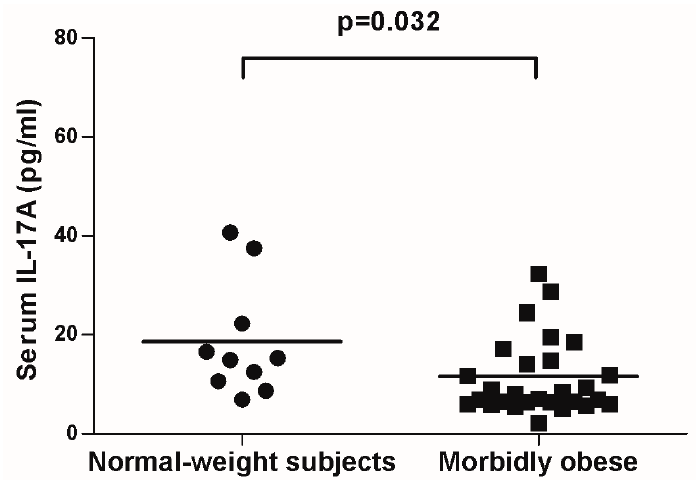
Figure 3. Circulating levels of IL-17A in normal-weight subjects (BMI < 25) and morbidly obese women (BMI > 40). Student’s t -test was used to compare the gene